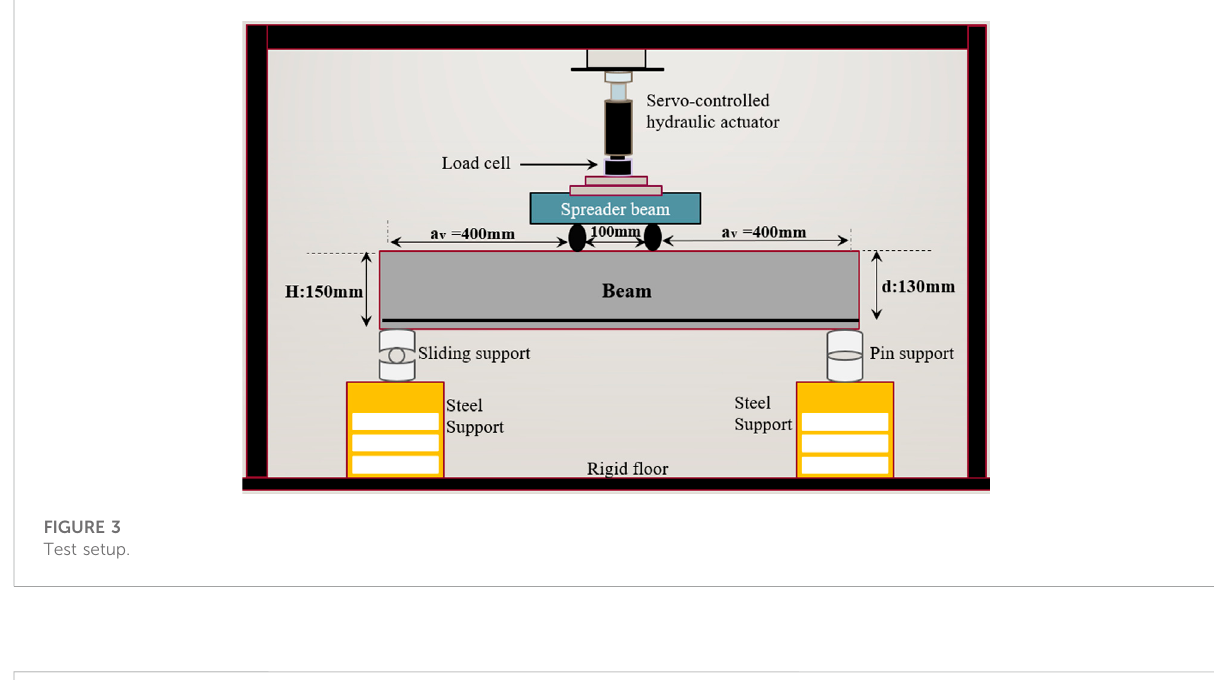
noteworthy bending cracks in the RCB depending on the vertical load. As presented in Figure 6, the bendings in the RCB are identi fi ed under the vertical loads. According to Figure 6, it is recognizably offered that important cracks (vertical and shear) are noticed in the RCB. The cracking of the RCBs taking place in the bending zone depending on the vertical load is realized in